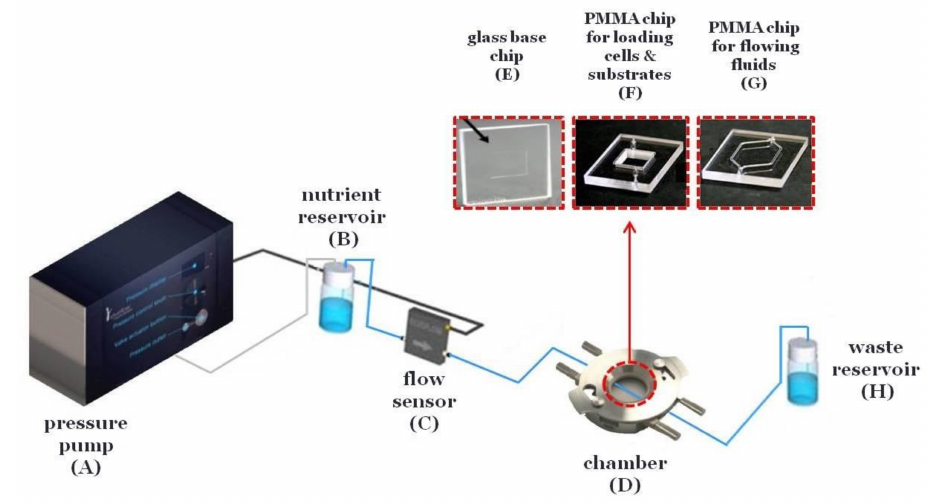
Figure 1. Illustration of the microfluidic system with precisely controlled flow. The microfluidic system is composed of a pressure pump ( A ) connected with a nutrient reservoir ( B ), a precisely controlled flow sensor ( C ), a chamber ( D ) including the microfluidic devices ( E , F or G ) and a waste reservoir ( H